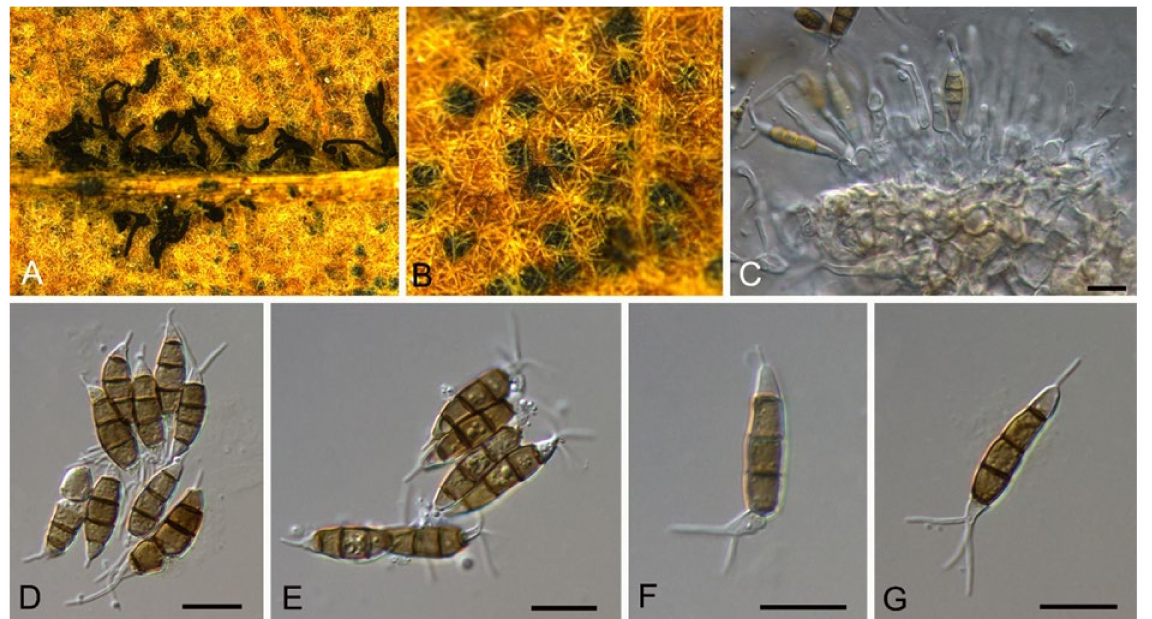
Figure 17. Neopestalotiopsis sp.1 (BJFC-S1787). ( A , B ) Conidiomata on the diseased leaves of Castanea mollissima ; ( C ) Conidio- genous cells giving rise to conidia; ( D – G ) Conidia. Scale bars: ( C – G ) = 10 µ